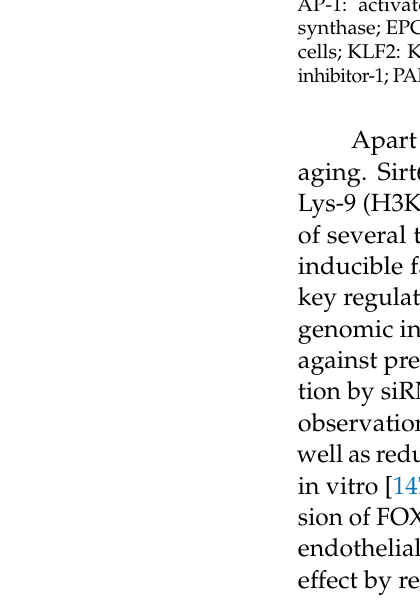
antioxidant genes